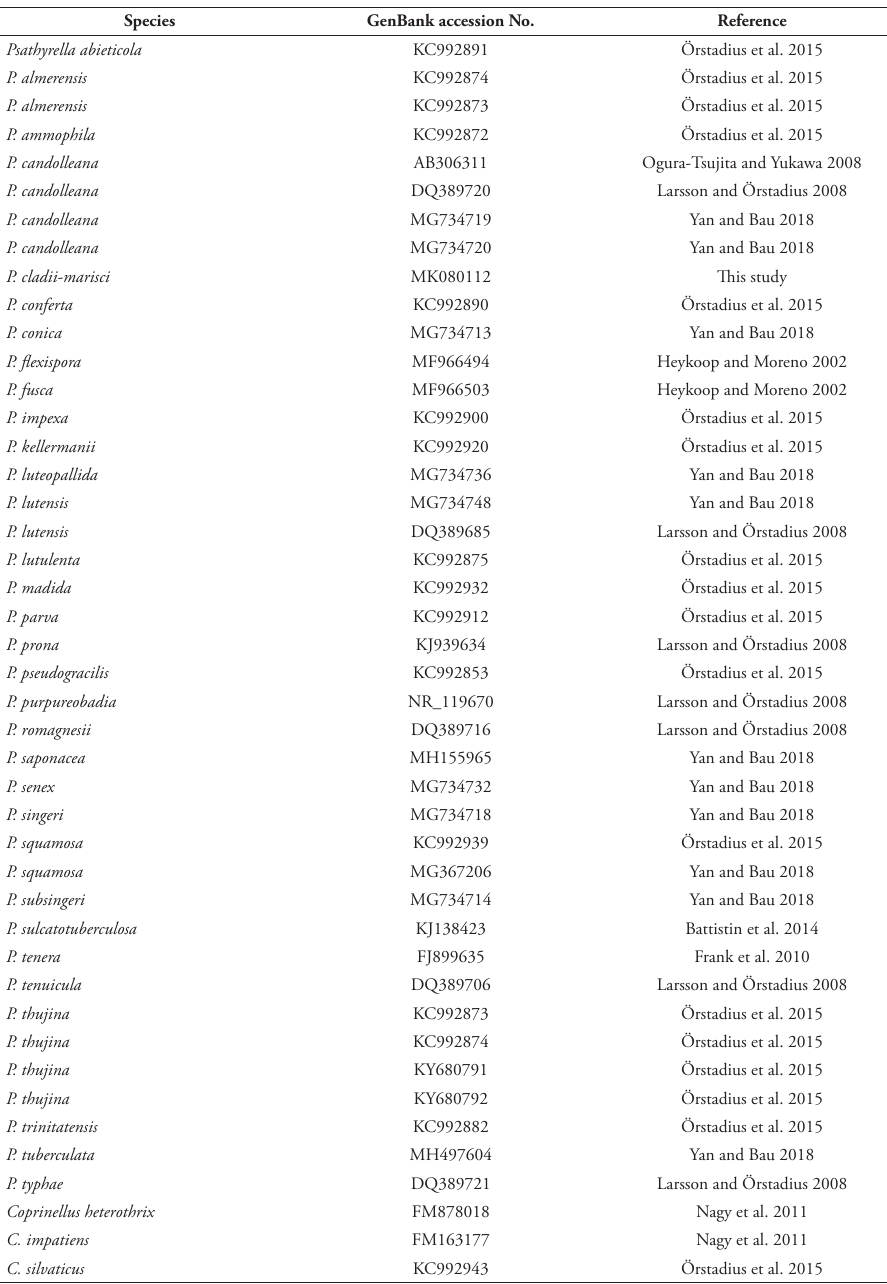
Table 2. Species used for the phylogenetic analyses including GenBank Accession Numbers and pub- lished